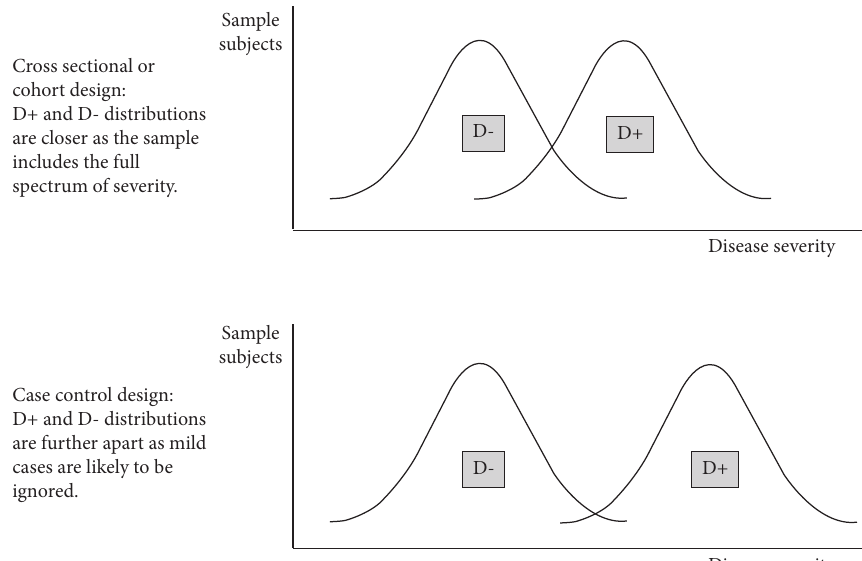
Figure 3: Cross-sectional study design minimizes spectrum bias as cases and controls are not sampled separately from the target population. D refers to disease status with D+ meaning disease is present and D-patients meaning disease is